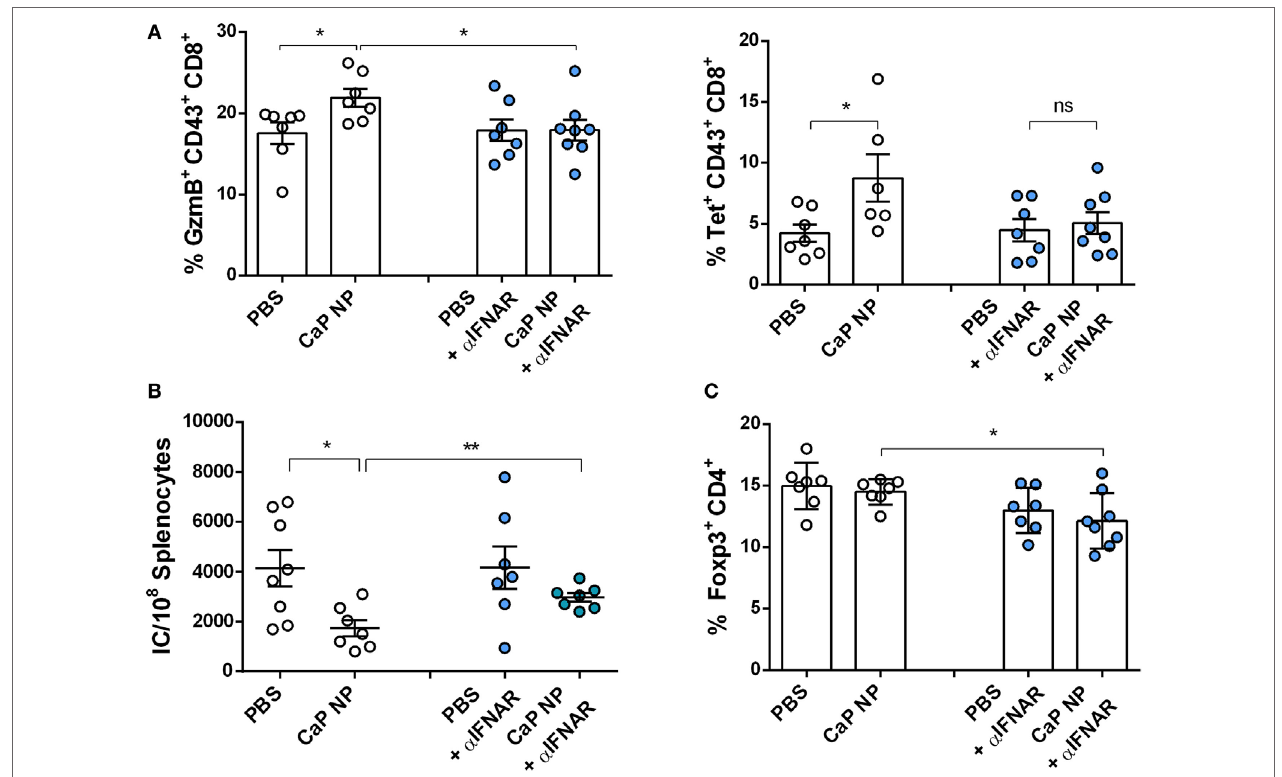
FigUre 5 | Blocking type I interferon signaling prevents reactivation of cytolytic CD8 + T cells. Chronically infected C57BL/6 mice were vaccinated subcutaneously either with phosphate-buffered saline (PBS) or CpG and FV peptide functionalized calcium phosphate (CaP) nanoparticles (NPs). IFNAR blocking monoclonal antibody was applied 1 day before and 2 days after vaccination. (a) Splenocytes were isolated 7 days postvaccination and stained for granzyme B expression in CD43 + CD8 + T cells and tetramer + FV-specific CD43 + CD8 + T cells. (B) Infectious centers in the spleen were determined 7 days postvaccination. (c) Splenocytes were stained for Foxp3 expression in CD4 + T cells. The results of two independent experiments are shown, n = 7–8. Bars represent mean ± SEM. Statistical analysis was performed by Student’s t -test (* p <